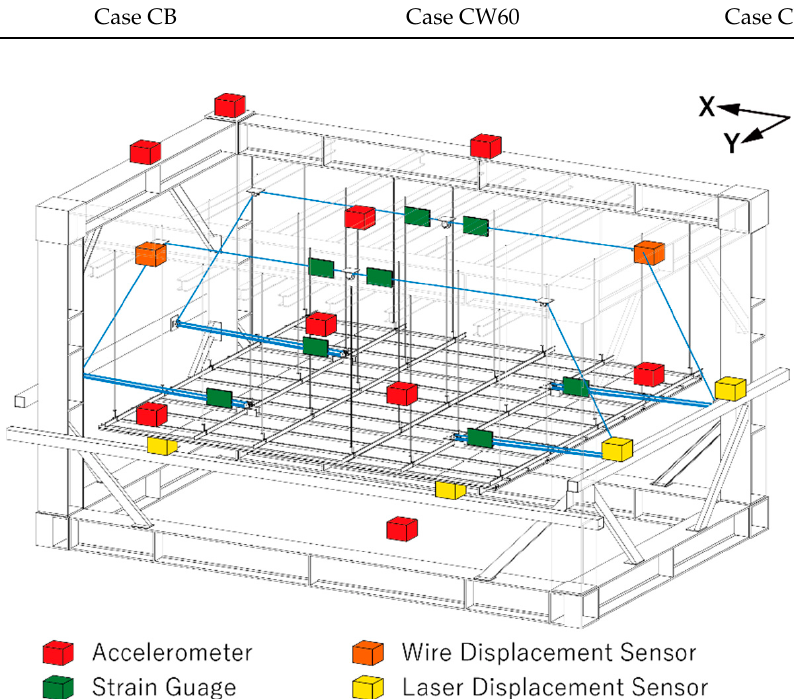
Figure 13. Measurement instrument location for the full-scale suspended ceiling system.